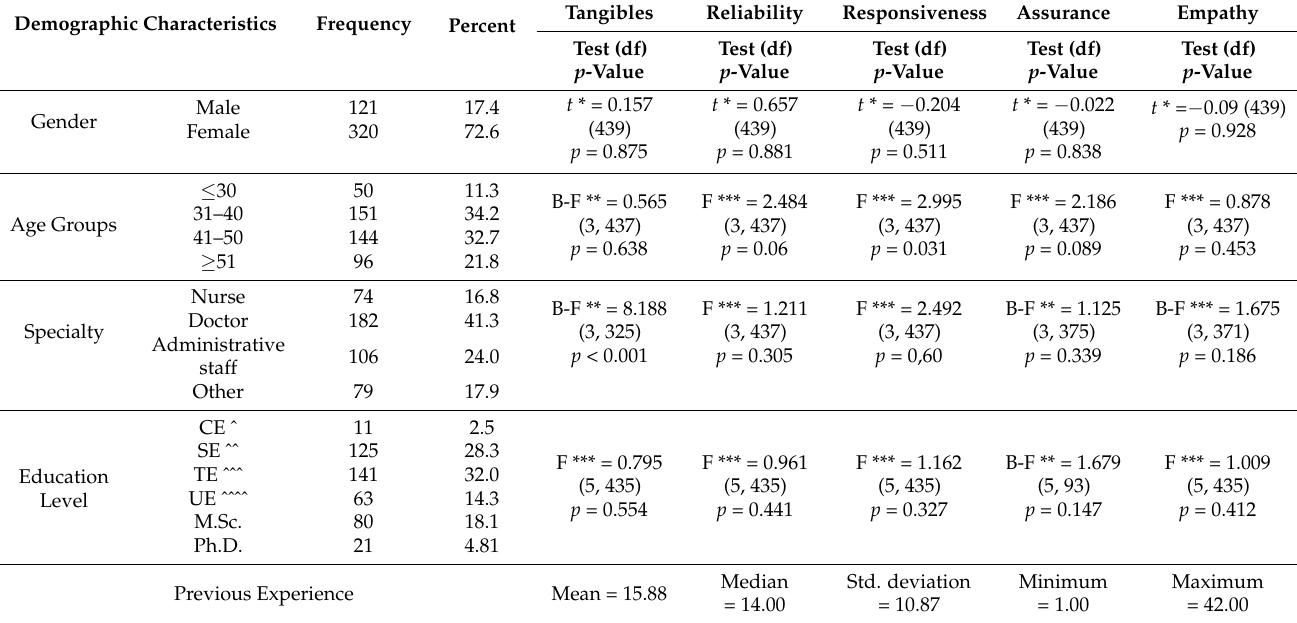
Table 3. Demographic characteristics of the respondents and impact evaluation of the demographic characteristics on internal quality